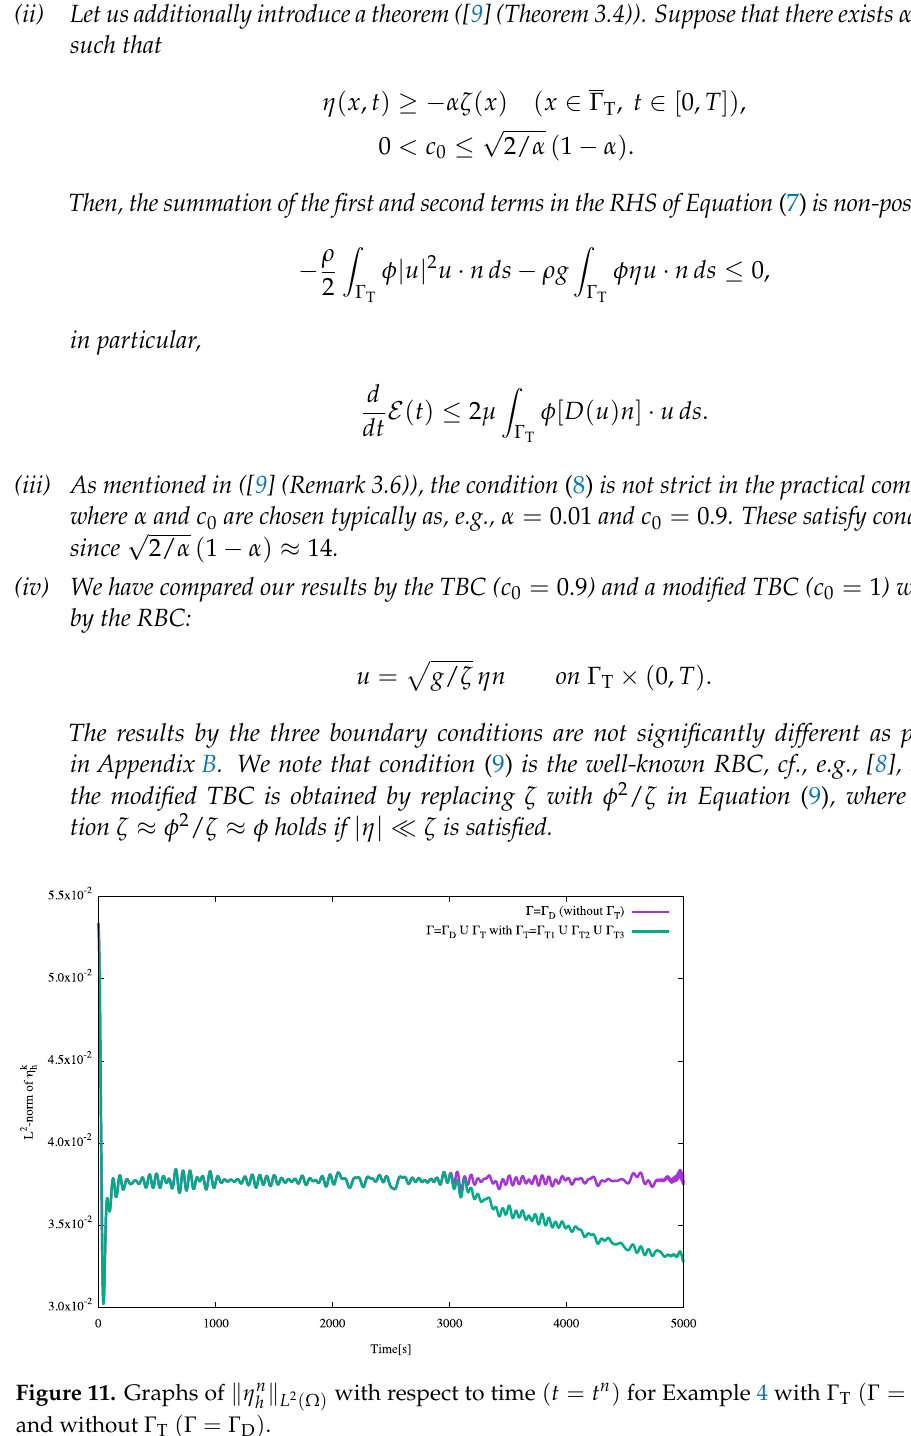
( t = t n ) for Example 4 with Γ